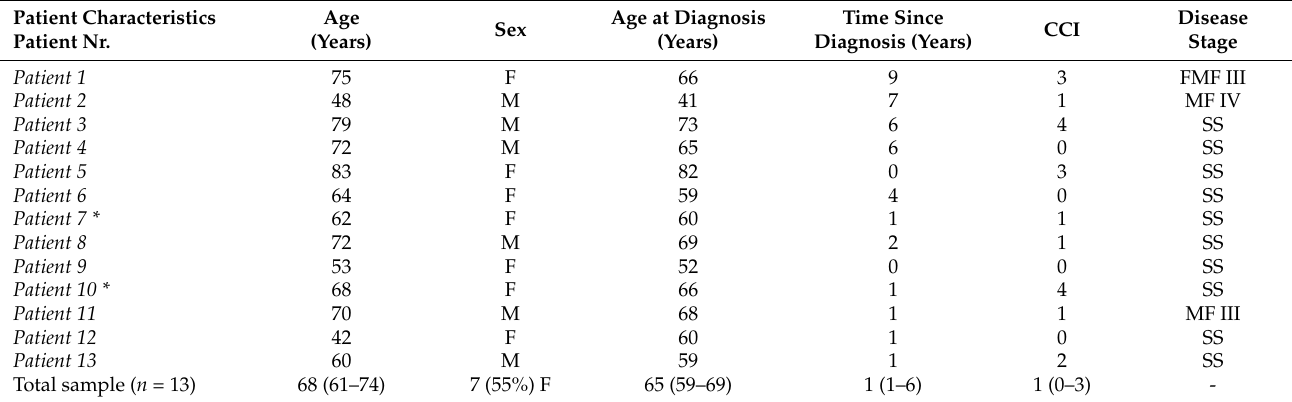
Table 1. Patient characteristics.